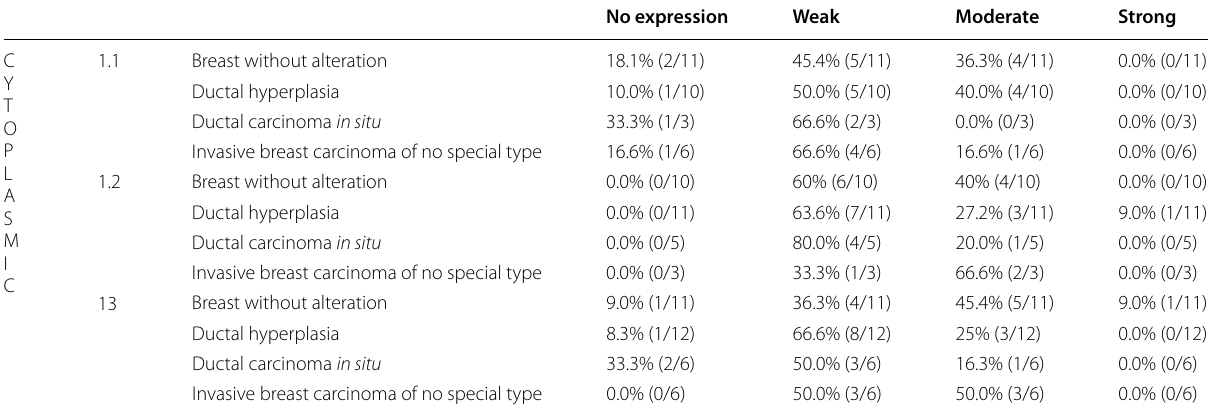
Table 3 Percentage of cases with cytoplasmic immunostaining categorized in no expression, and weak, moderate, or strong intensity of Ca 1.1, Ca 1.2 and Ca 1.3 immunostaining in all analysed regions. Cytoplasmic immunoexpression is seen for all channels in V V V